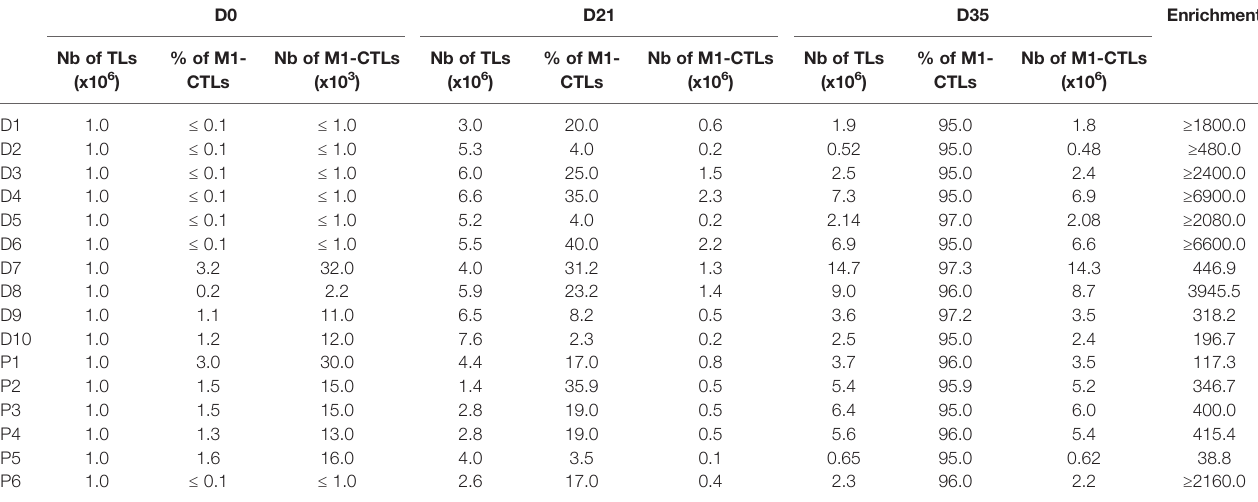
TABLE 1 | Increase in M1-CTLs with the AAPC-based protocol.